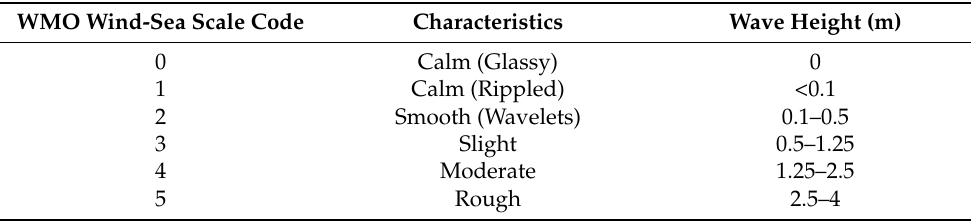
Table 1. World Meteorological Organization(WMO) wind-sea scale code.